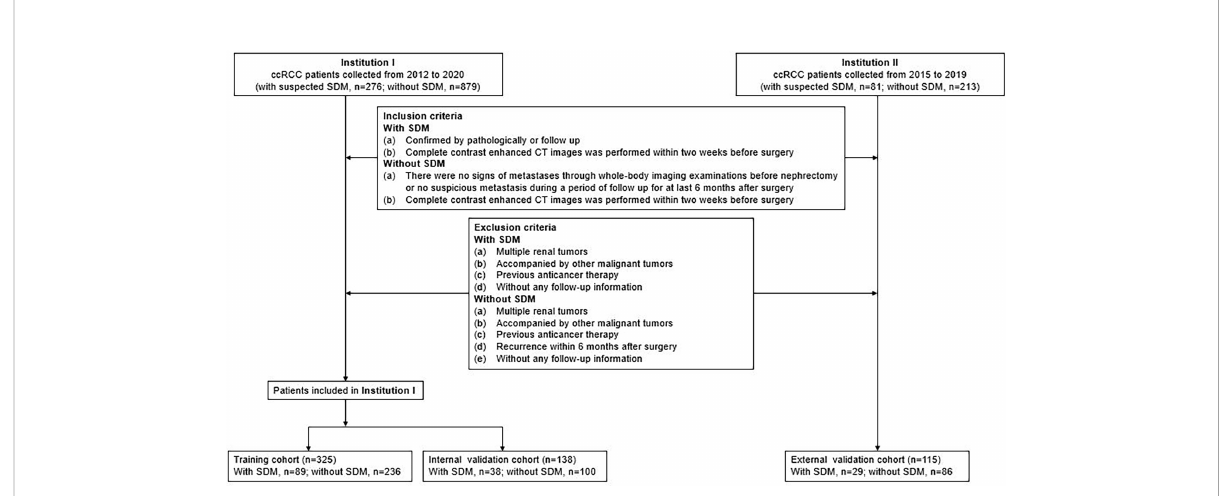
FIGURE 1 Recruitment pathway for patients in this study. ccRCC, clear cell renal cell